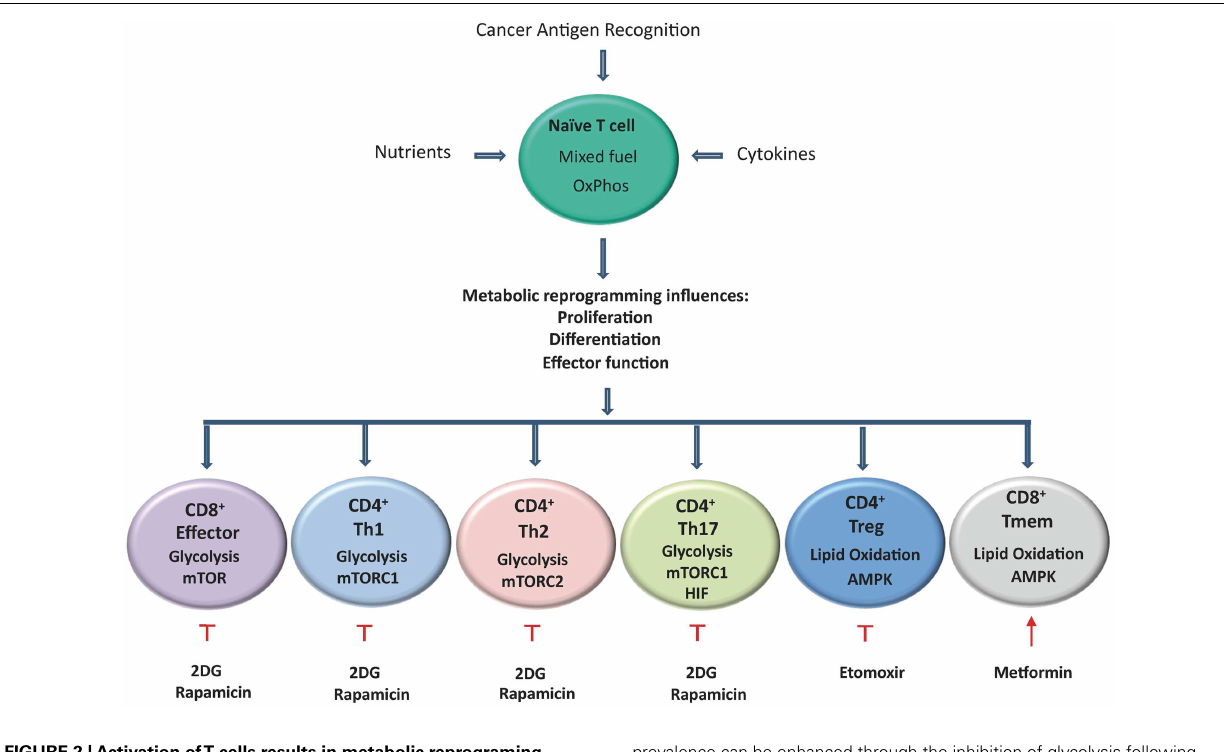
FIGURE 2 |Activation ofT cells results in metabolic reprograming, which influences their proliferation, differentiation, and effector functions. Aerobic glycolysis becomes the predominant metabolic pathway used by CD8 + effector cells, CD4 + Th1,Th2, andTh17 cells, by contrastT REG andT MEM rely on lipid oxidation.T cells that differentiate into Th17 cells primarily rely on glycolysis controlled by HIF-1 α .T MEM andT REG rely on lipid oxidation under the control of AMPK.Tumor specificT MEM cell